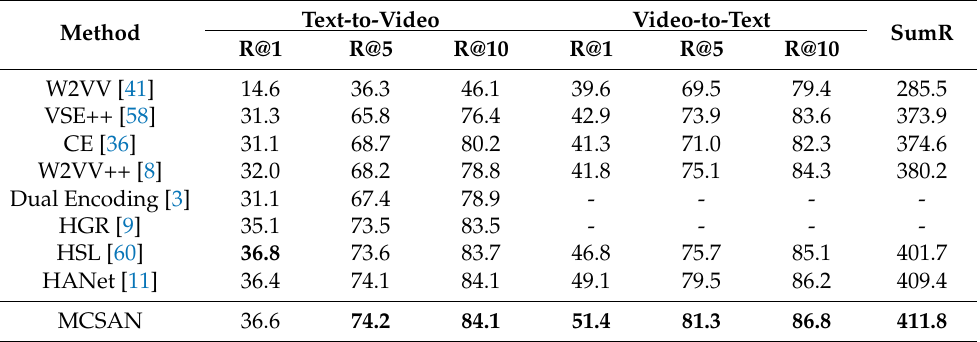
Table 2. Comparisons with the state-of-the-art video–text retrieval methods on the VATEX dataset. The best performance are marked in bold. The overall performance are indicated by Sum of Recalls (SumR). MCSAN is the